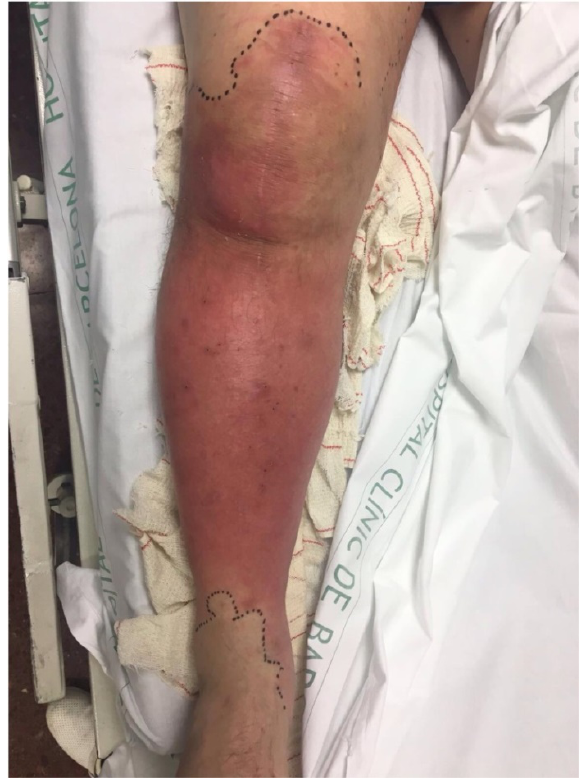
Figure 1 . Patient with a cellulitis of the right lower leg covering the prosthetic joint that was implanted the year prior to presentation. The scar of the primary arthroplasty is still visible. Streptococcus dysgalactiae was cultured in multiple deep tissue biopsies during surgical debridement.